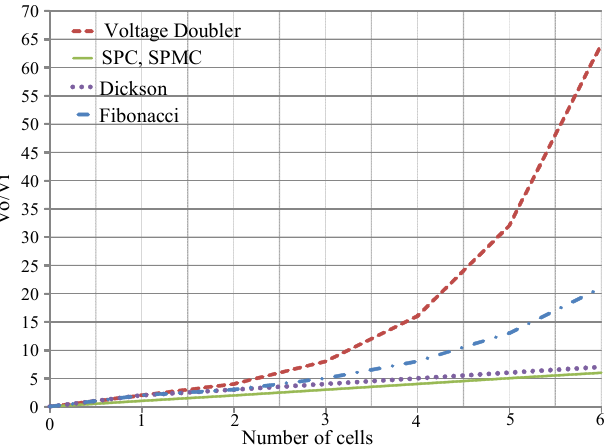
Figure 16. Behavior of the voltage gain of SC converters as a function of the number of cells. To analyze the behavior of the output voltage, the circuit represented in Figure 17 is adopted. In this case, the converter can be modeled as an ideal transformer with turns ratio m : n , where R o is the equivalent output resistance of the SC converter, which is connected in series with the load R L [86,111]. In this model, the resistance R o controls the power transferred to the load and the output voltage regulation. The variation of R o in practice is mainly associated with the switching frequency and the internal resistance of the converter